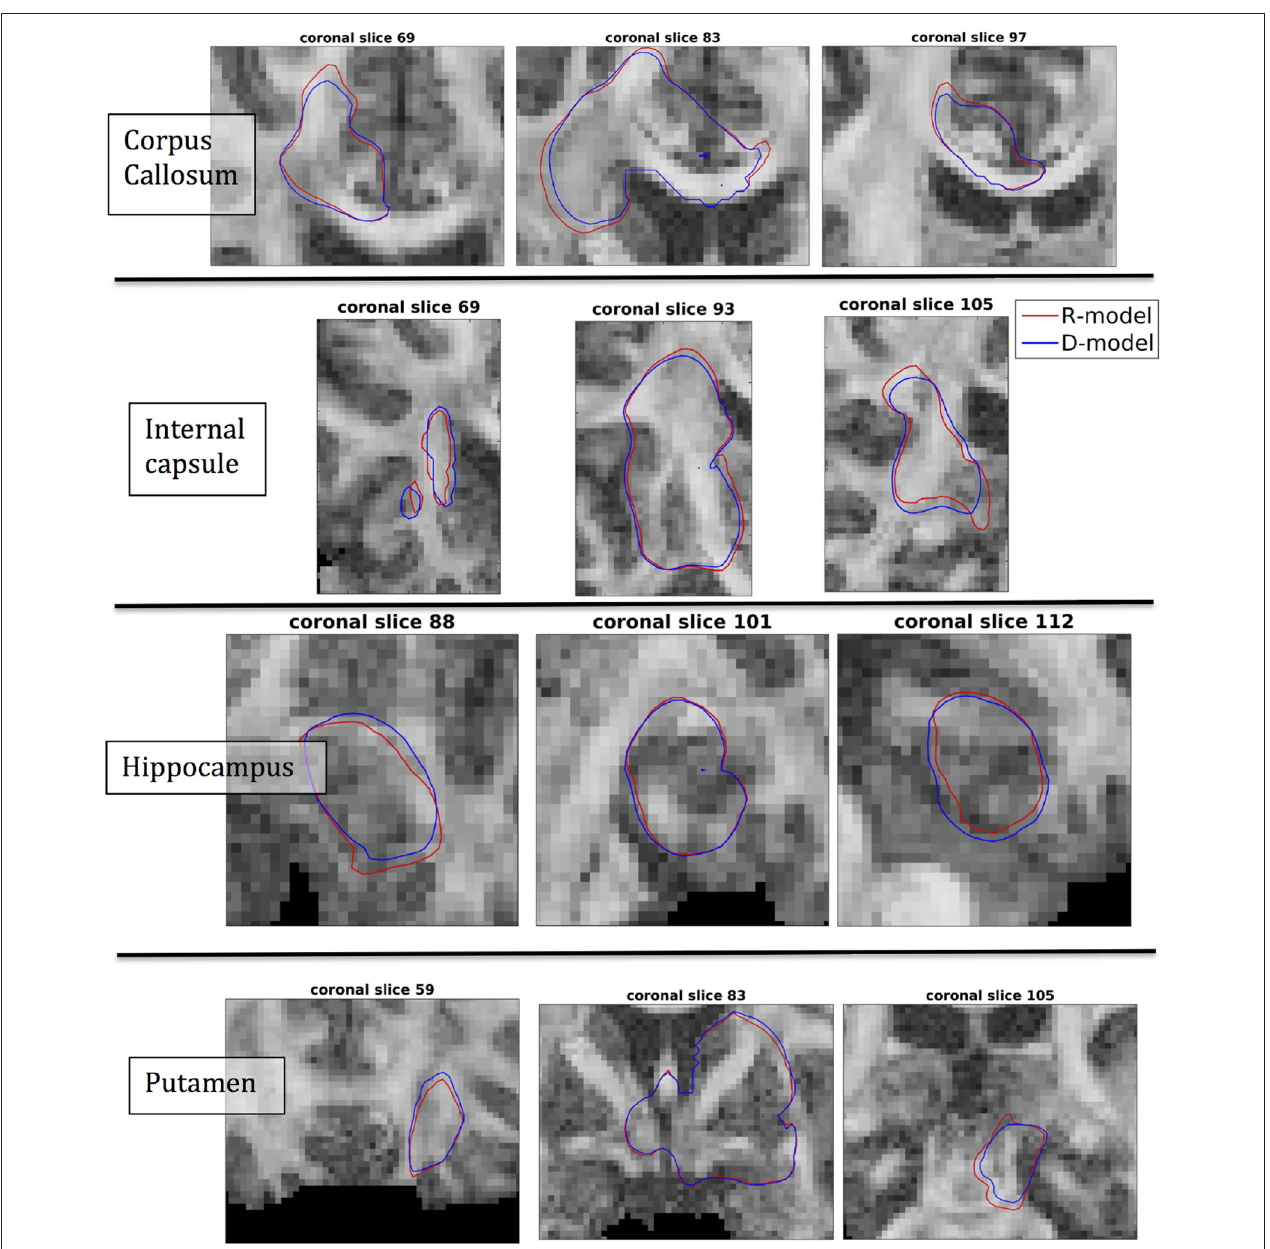
FIGURE 12 | Distribution volumes (i.e., volumes where the drug reaches a concentration that is at least 5 % of the maximum concentration) predicted by the R-model (red curves) and by the D-model (blue curves), for the 4 infusion sites used in our simulations. Accounting for diffusion non-Gaussianity results in distribution volumes that are less smooth and more anisotropically defined, following the anisotropy of the underlying